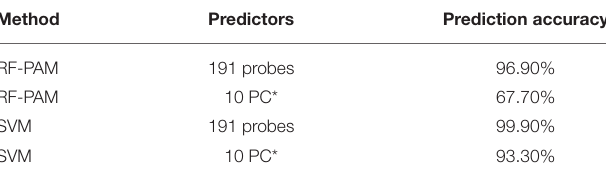
TABLE 2 | Predicting performance of two machine learning